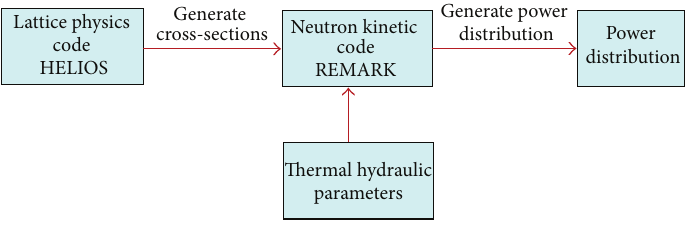
Figure 4: Flow diagram for verification studies.